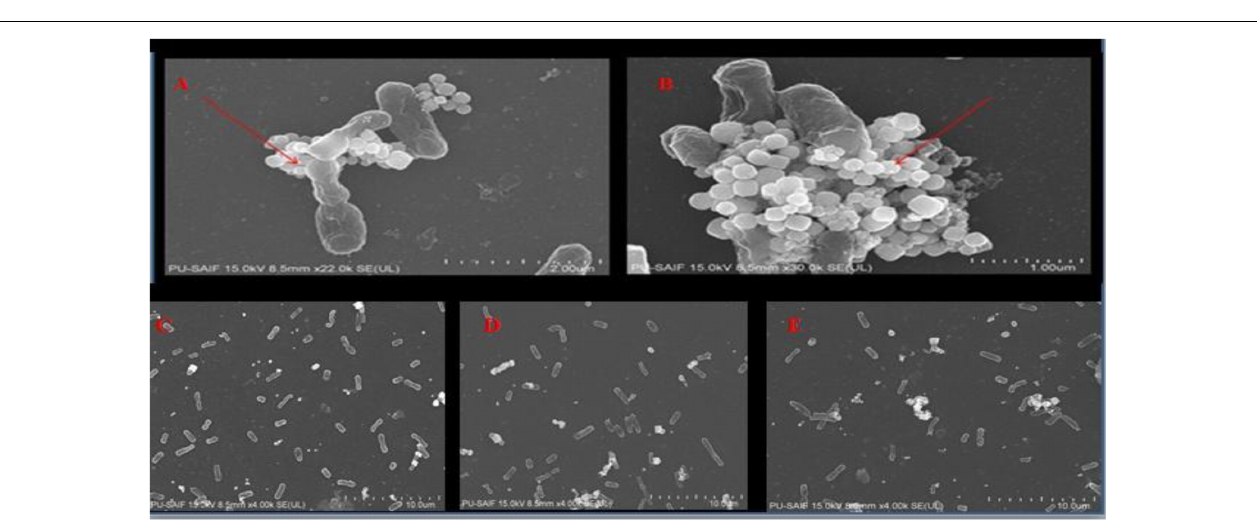
FIGURE 5 | FESEM images (A,B) H-AgNPs were seen interacting with cells of K. pneumoniae ( × 22k-30k magnification at 15 kV). (C–E) Different fields showing loss of biofilm integrity ( × 4k magnification at 15 kV).